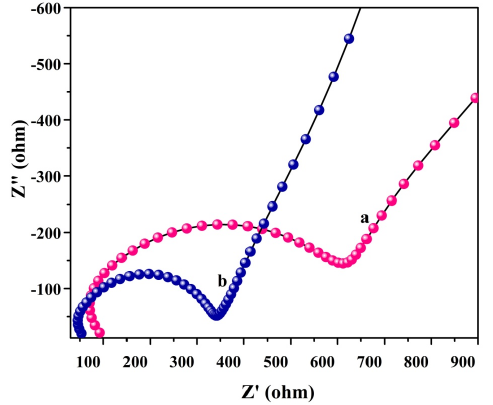
Figure 2. Nyquist plots of BCPE ( a ) and EPGNLCPE ( b ).